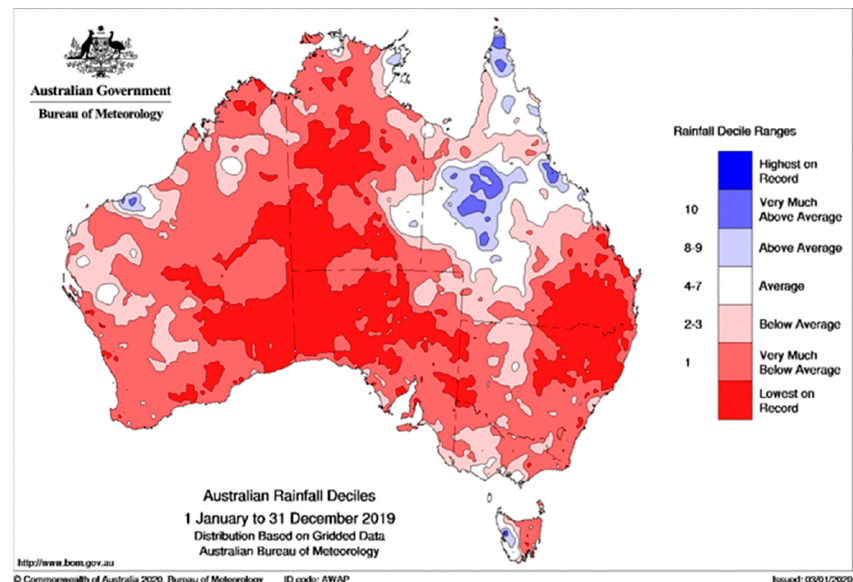
Figure A2. 2019 rainfall deciles in Australian continent. Source: Bureau of Meteorology